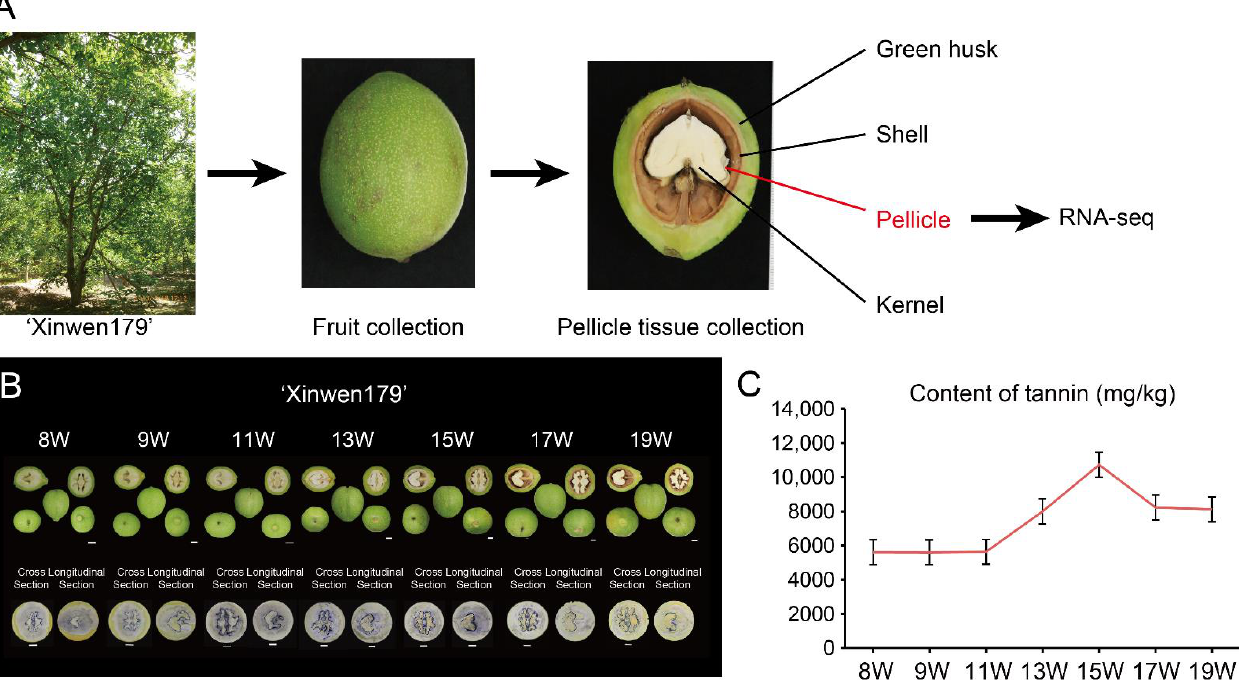
Figure 1. Phenotype and dynamic content of tannin in walnut variety ‘ Xinwen179 ’ . ( A ) Overview of the experimental design. The fruits of early-flowering walnut cultivar ‘Xingwen 179 ’ were har- vested at seven stages (8 W, 9 W, 11 W, 13 W, 15 W, 17 W, and 19 W). RNA-seq was performed with three biological repeats; ( B ) he phenotype of walnut variety ‘ Xinwen179 ’ from 8 W to 19 W, showing the appearance of fruit (upper panel) in cross- and longitudinal sections (bar = 1 cm); ( C ) Tannin content with three biological replicates (rep).